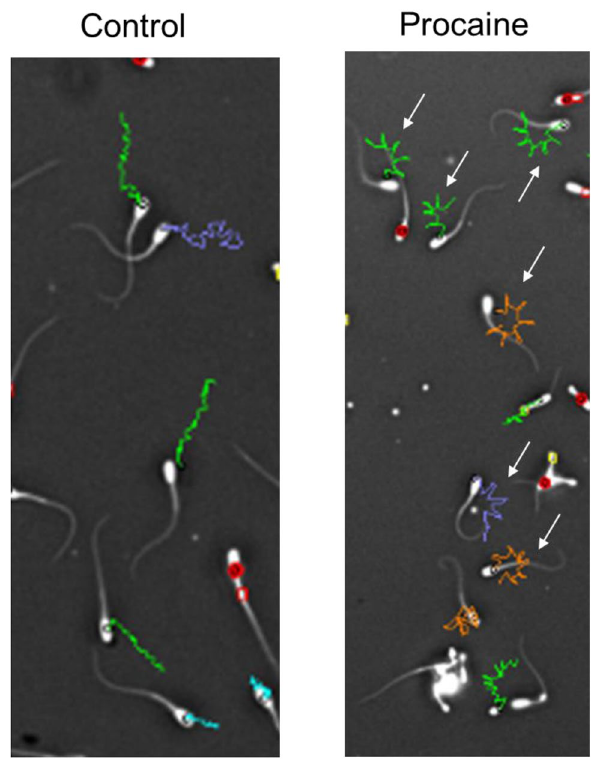
Figure 3. Representative motility tracks of spermatozoa after centrifugation and incubation in non-capacitating Tyrode’s medium without (control) or with procaine. The stimulatory effect of procaine can be inferred from the star-like tracks in the right picture (white arrows). Images are screenshots from computer-assisted semen analysis